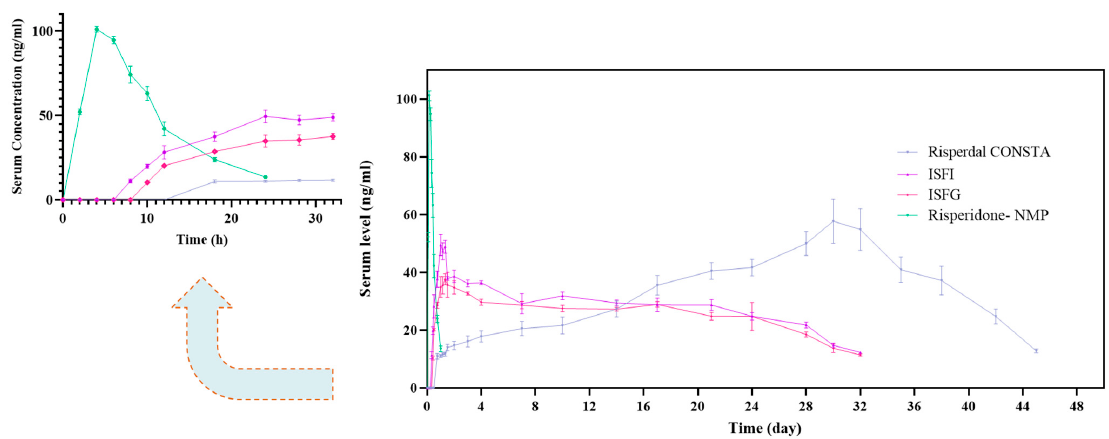
Figure 5. Diagram of blood concentration of risperidone after in-vivo administration of 25 mg risperidone in optimal ISFG, ISFI, risperidone solution in NMP, and Risperdal CONSTA ® . Table 2. Pharmacokinetic parameters resulting from the administration of formulations containing 25 mg of risperidone to rabbits (n = 3) using PK solver software.